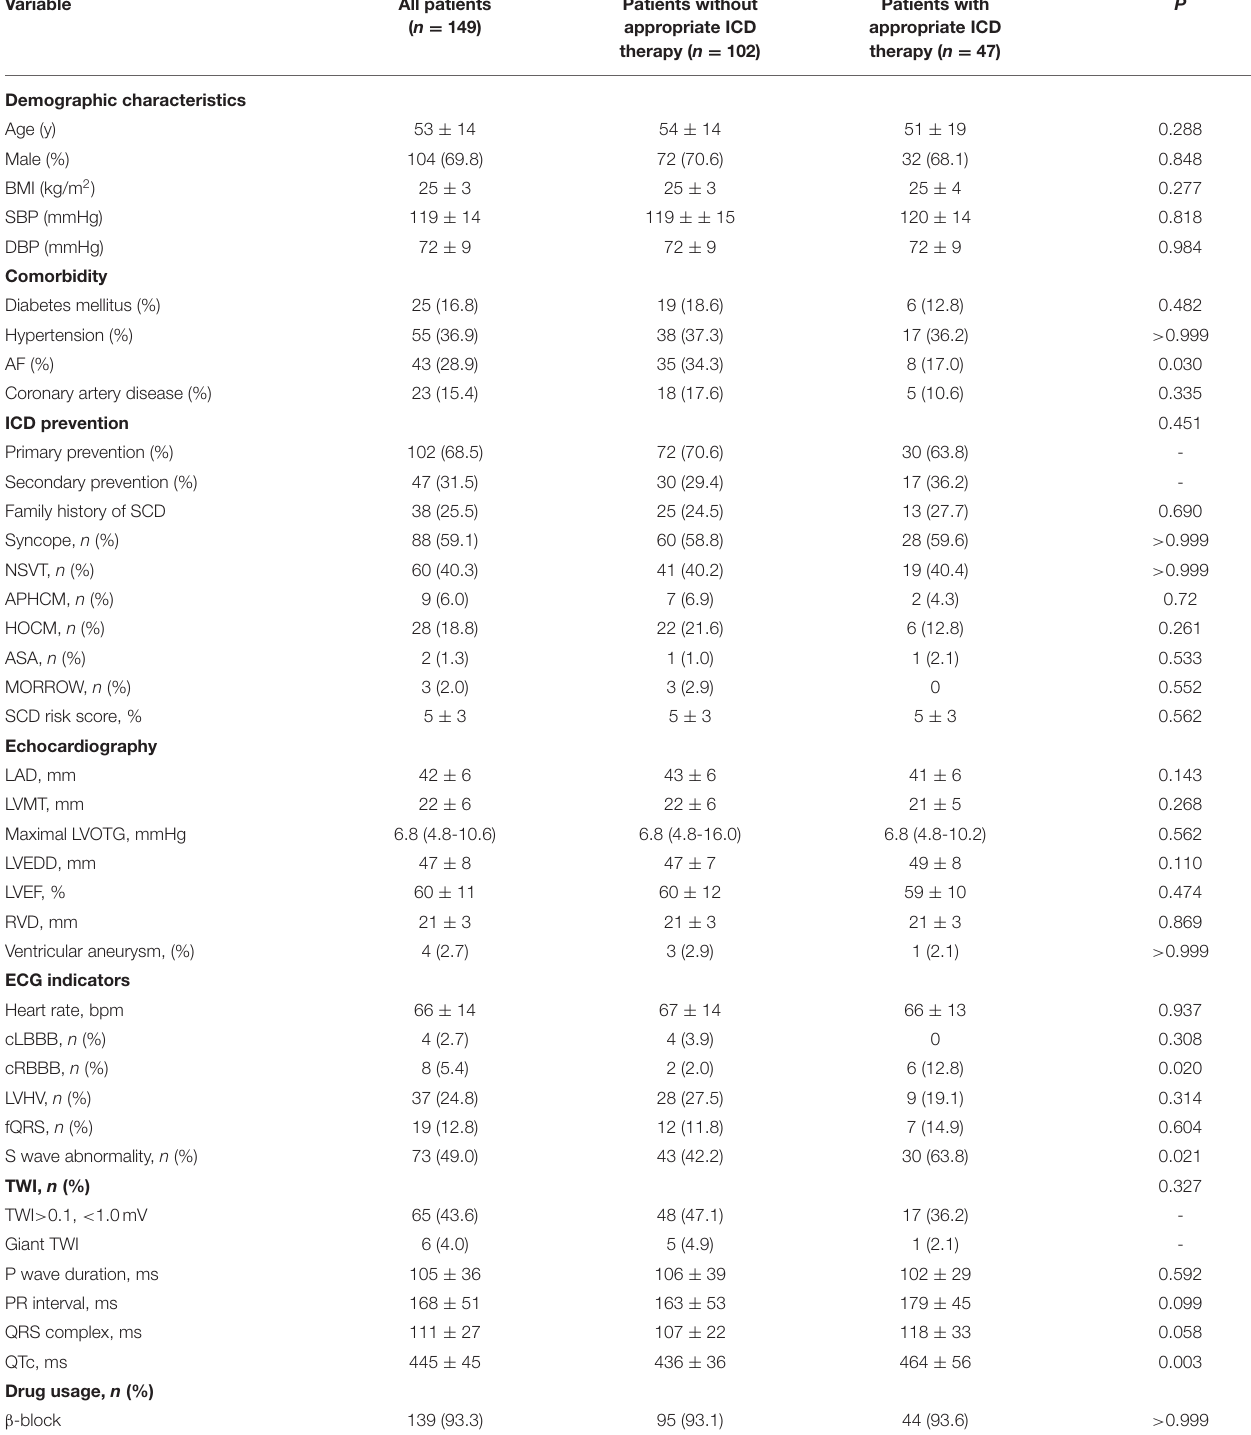
TABLE 1 | Baseline characteristics of HCM patients with and without appropriate ICD therapy. Variable All patients